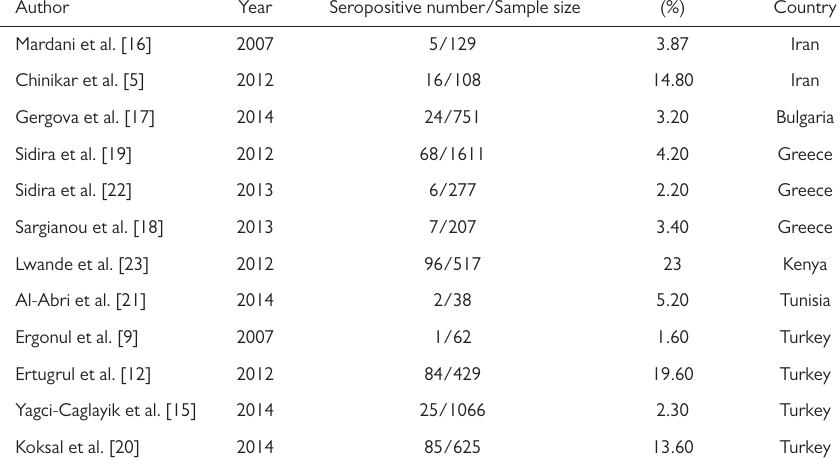
Table 2. Scientific data from around the world on anti-CCHFV IgG positivity